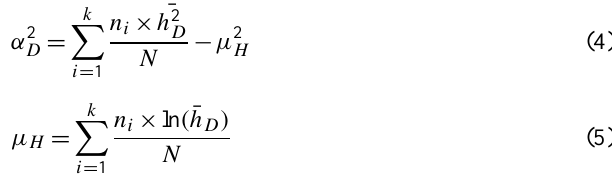
Table 1. Values for the obtained parameters ¯ h D and α D for the fragility functions we derived. R 2 is the linear regression coefficient determined through the least-squares fitting for each fragility curve.